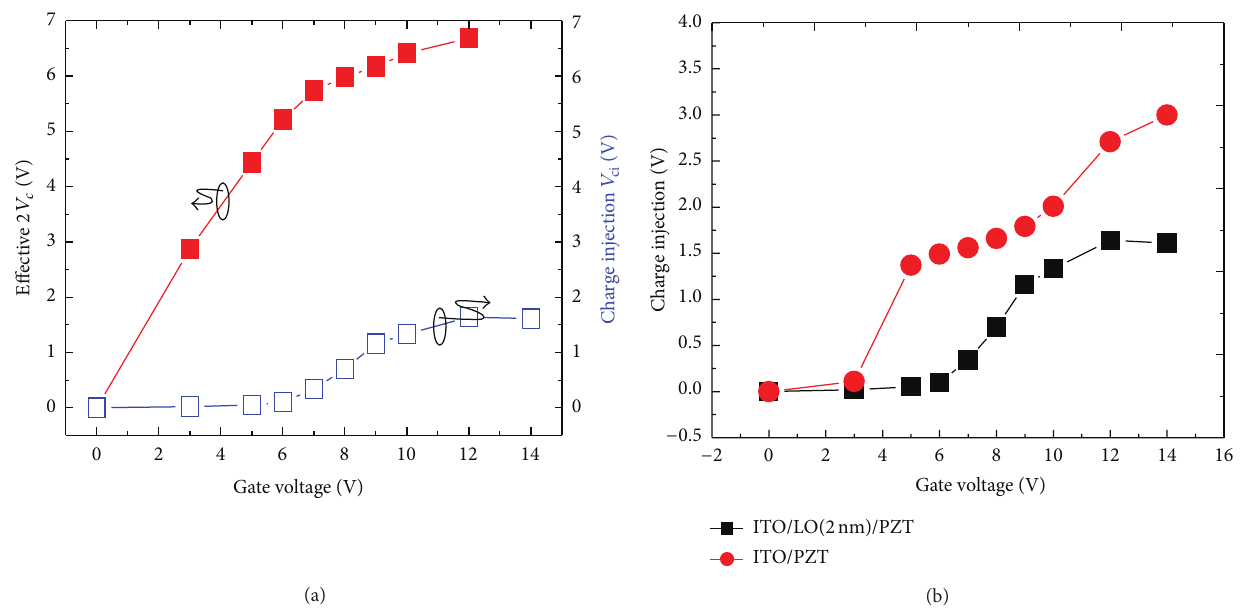
Figure 7: Effective coercive voltage ( 2𝑉 𝑐 ) applied to PZT films and reduction values ( 2𝑉 𝑐 − 𝑉 𝑚 ) of memory window by charge injection in the ITO/LO/PZT structure. The values of charge injection are 2𝑉 𝑐 − 𝑉 𝑚 at the same gate voltage, where 2𝑉 𝑐 is twice the coercive voltage at the real applied voltage on the PZT film